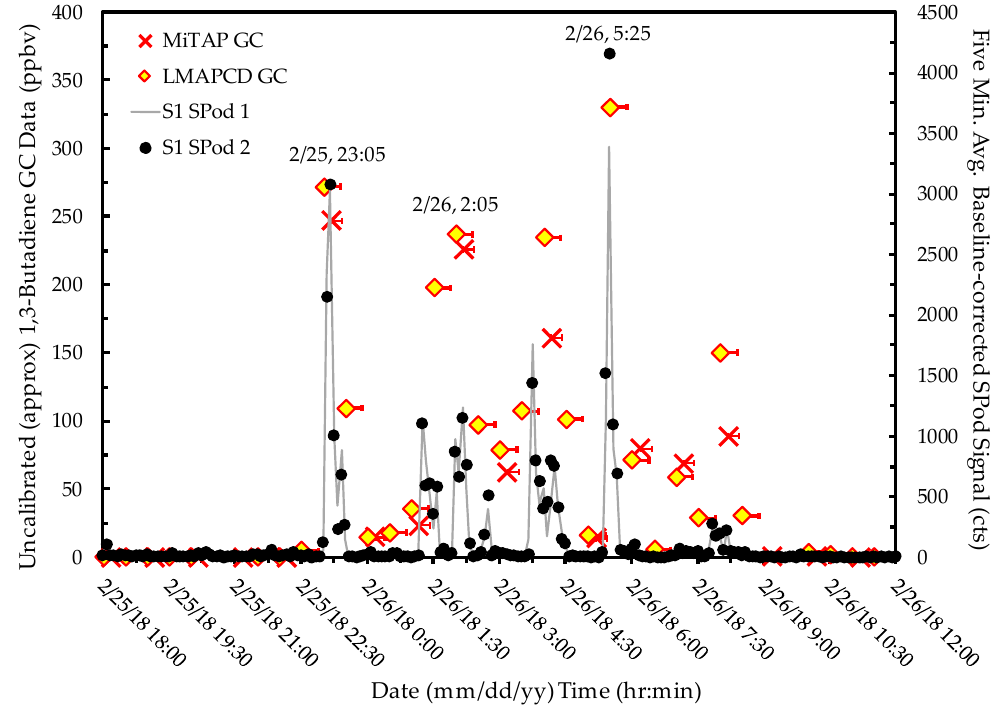
Figure 4. Time-resolved measurements of SIS1 event with SPod data averaged to five minutes. Single side horizontal error bars in GC data indicate the temporal extent of air sampling. Due to observed concentrations well beyond instrument calibration ranges, the GC data are considered approximate.